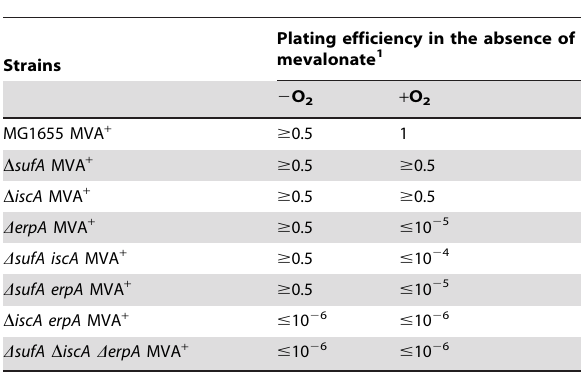
Table 4. Functional redundancy between sufA , iscA and erpA